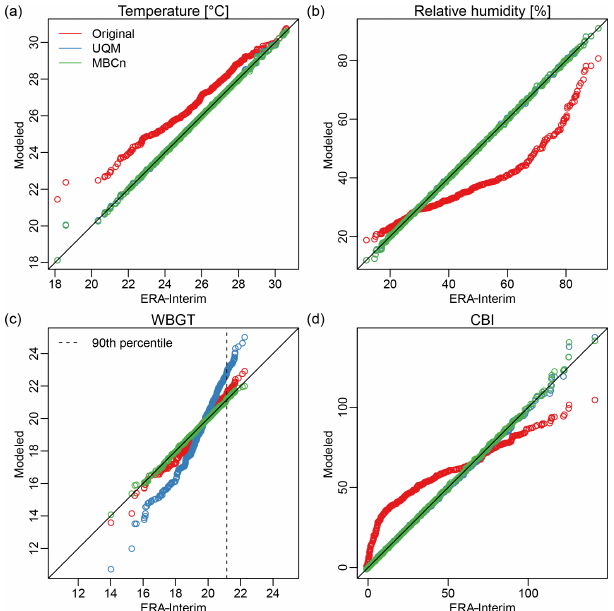
Figure 2. Quantile–quantile plot of observed versus modeled val- ues for temperature (a) , relative humidity (b) , heat stress (WBGT, c ) and fire risk (CBI, d ) for a grid point in central Africa; original model output (from IPSL-CM5A-MR) in red, model output cor- rected with UQM in blue, model output corrected with MBCn in green. The vertical dashed line in (c) shows the 90th percentile of observed WBGT. The same data as in Fig. 1 were used. Note that in panels (a, b, d) the green circles cover most of the blue circles, as in these cases both bias adjustments yield virtually identical